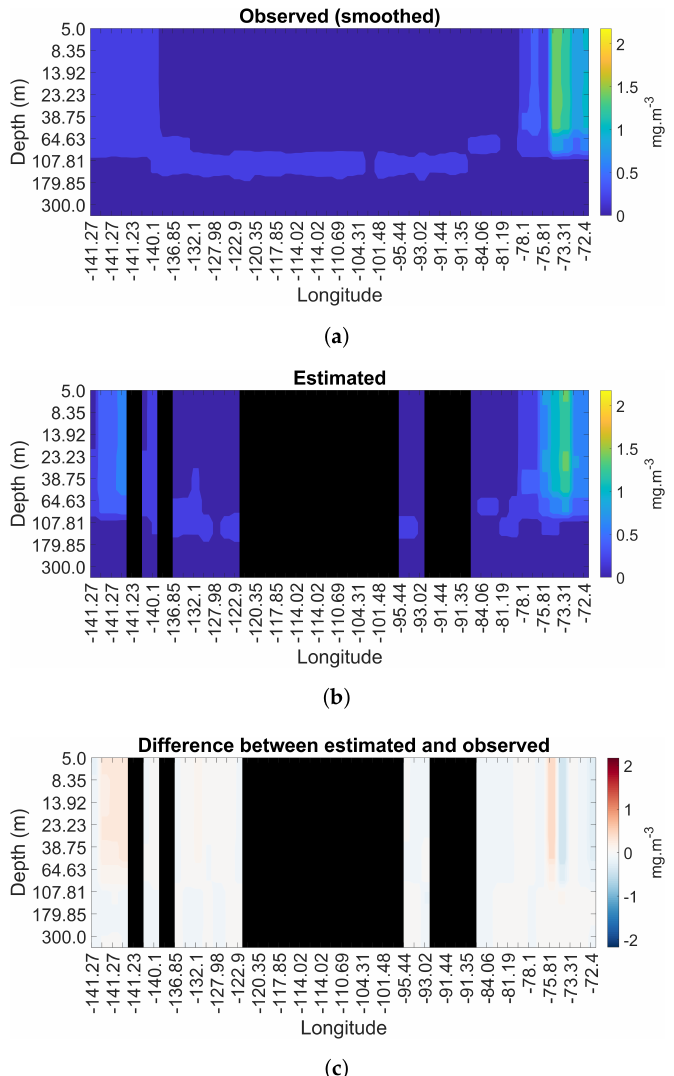
Figure 3. Result of the inversion of Chla profiles from the satellite data of the Biosope trajectory. ( a ) Smoothed observed Chla profiles; ( b ) estimated Chla profiles; ( c ) difference between estimated and observed.